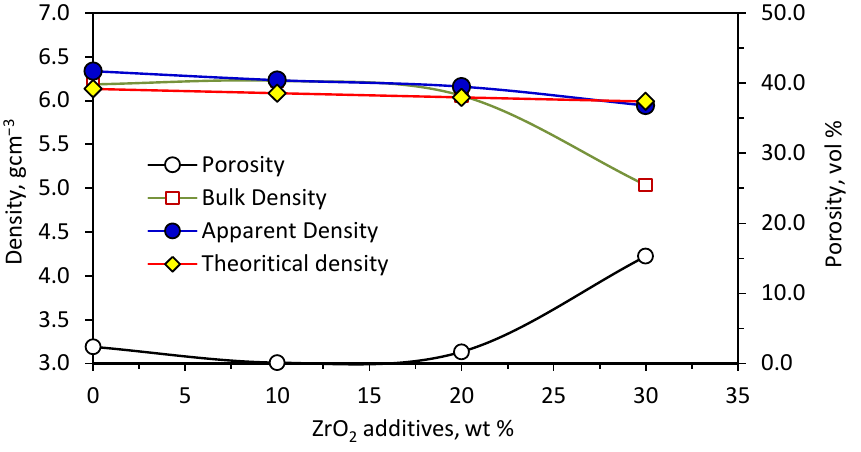
Figure 4. Effect of ZrO 2 amounts on the ZrN/ZrSi 2 - samples’ porosity, bulk, apparent and theoretical densities (prepared at 234 MPa).